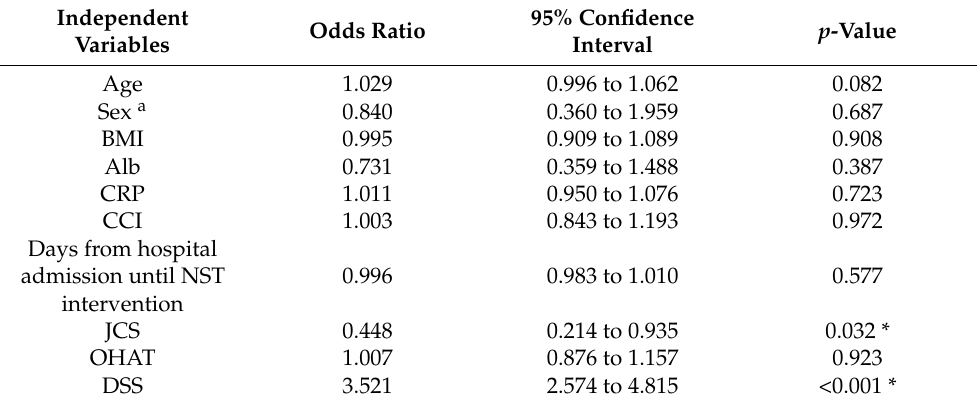
Table 3. Logistic regression analysis with oral intake as the primary nutrition route being the